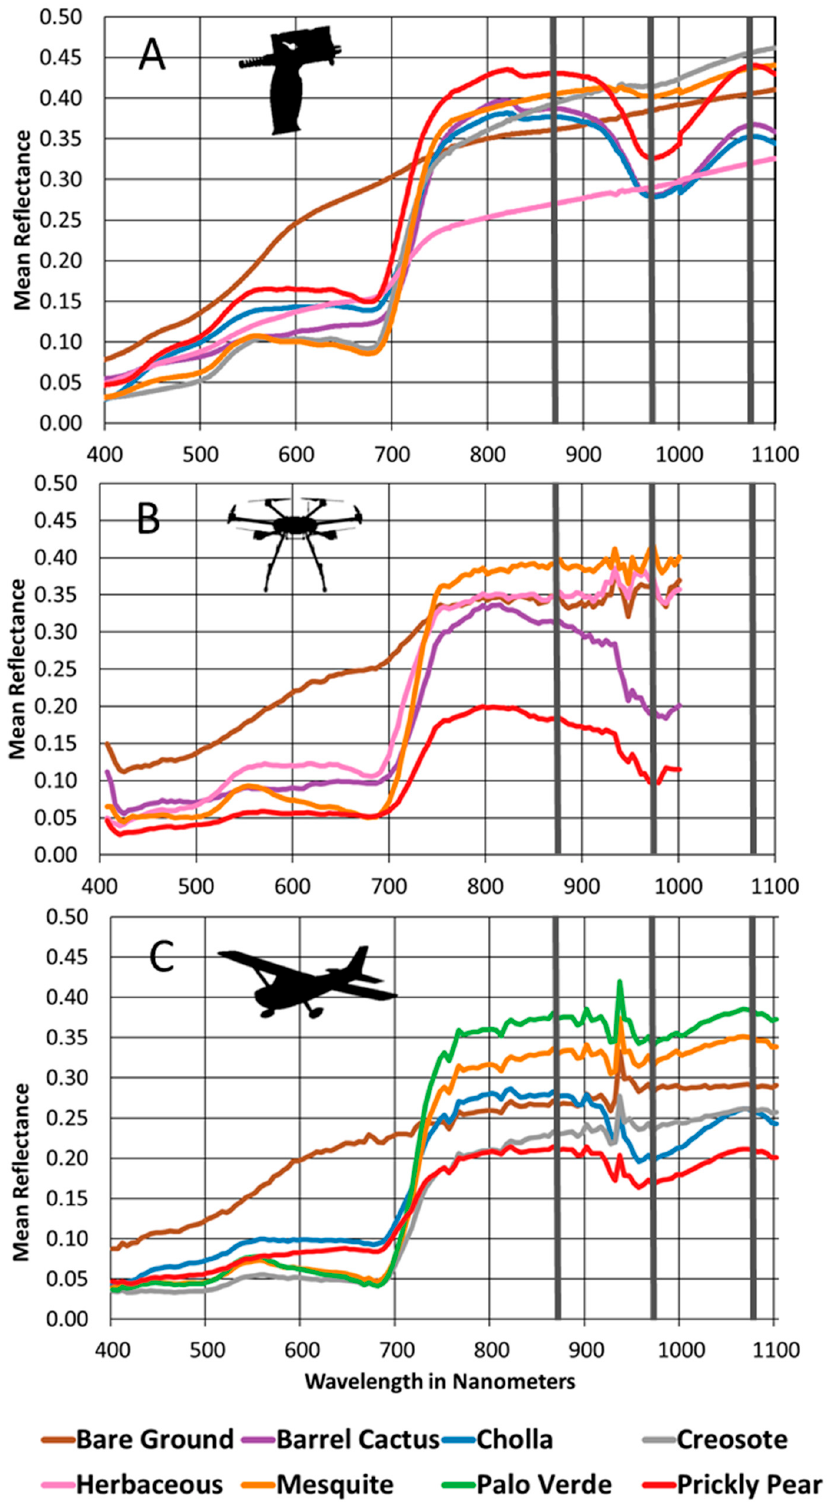
Figure 2. Average spectral signatures of mesquite (orange line), creosote (grey line), bare ground (brown line), herbaceous (pink line), barrel cactus (purple line), cholla (blue line), and prickly pear (red line), as measured from by the ASD spectroradiometer ( A ), drone-mounted Nano Hyperspectral sensor ( B ), and airplane-mounted NEON AVIRIS ( C ). The three dark grey lines represent the three portions of the electromagnetic spectrum used to calculate the two cacti indices.